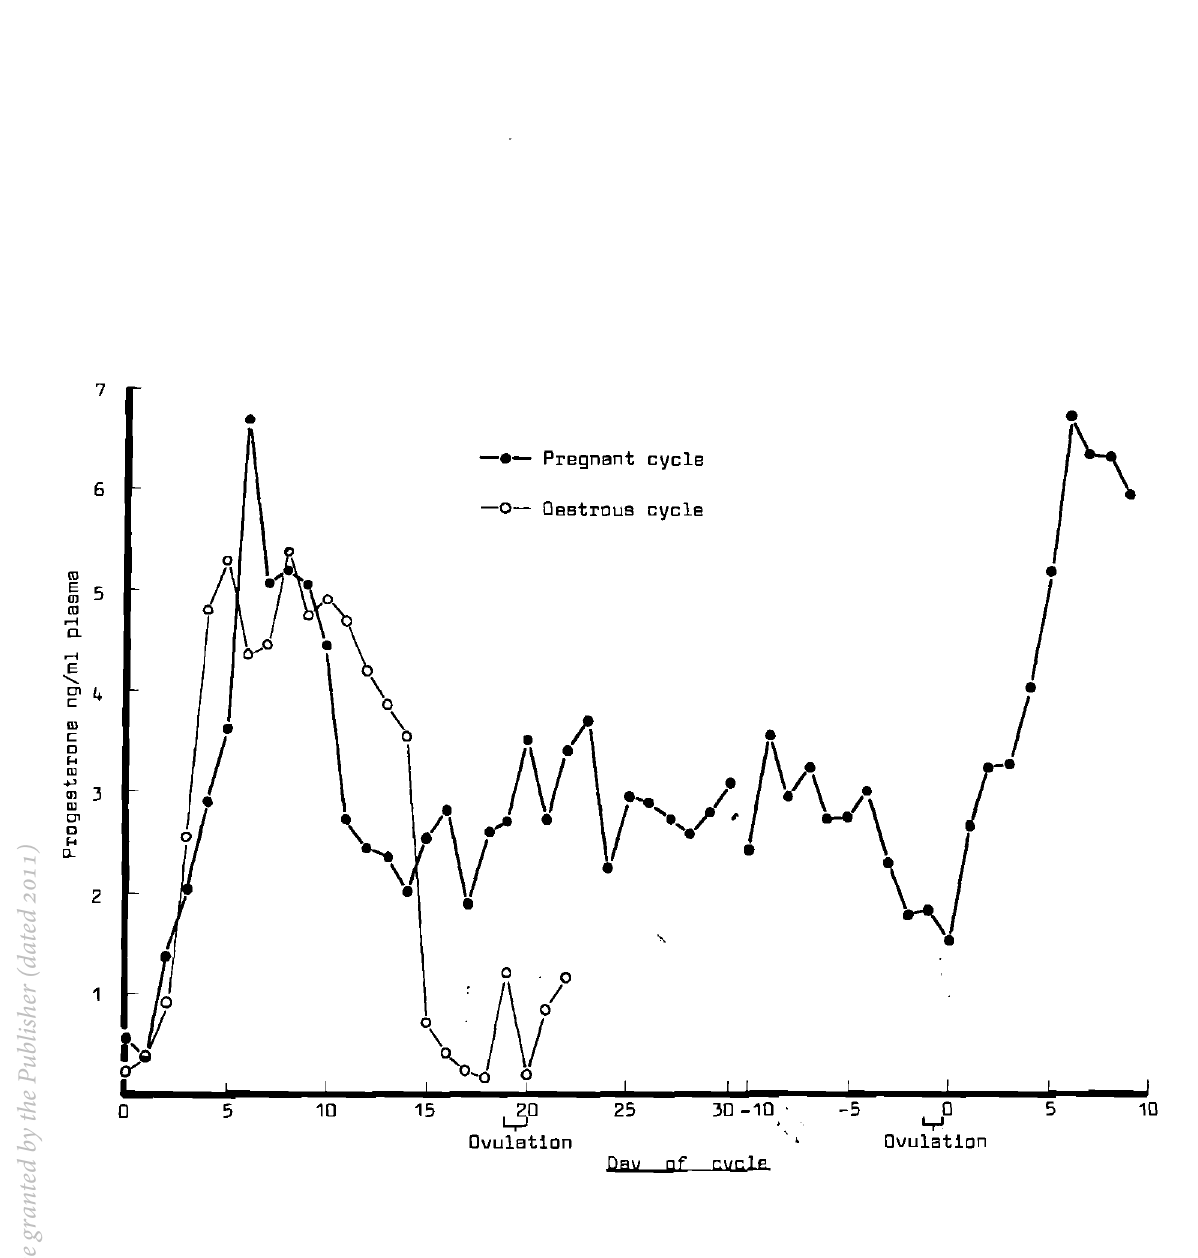
Fig. 3: Mean plasma progesterone concentrations in mares during four oestrous cycles and during four early pregnancies.